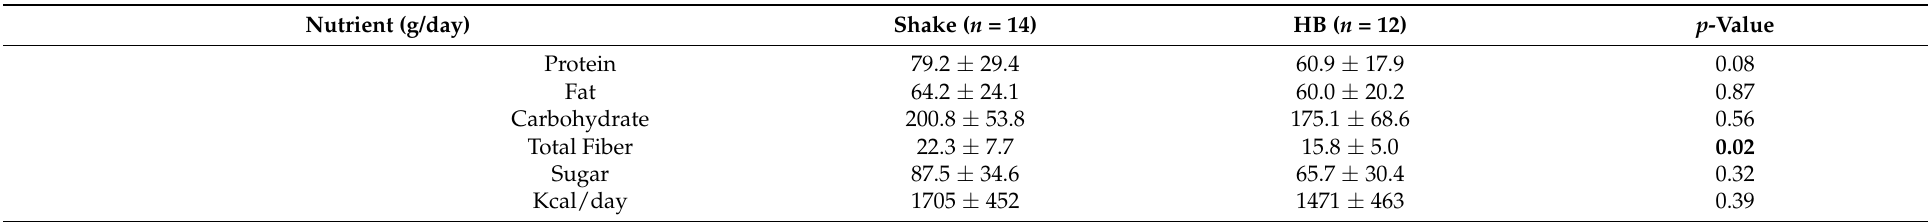
Table A2. Nutrient analysis for Shake vs. Habitual Breakfast